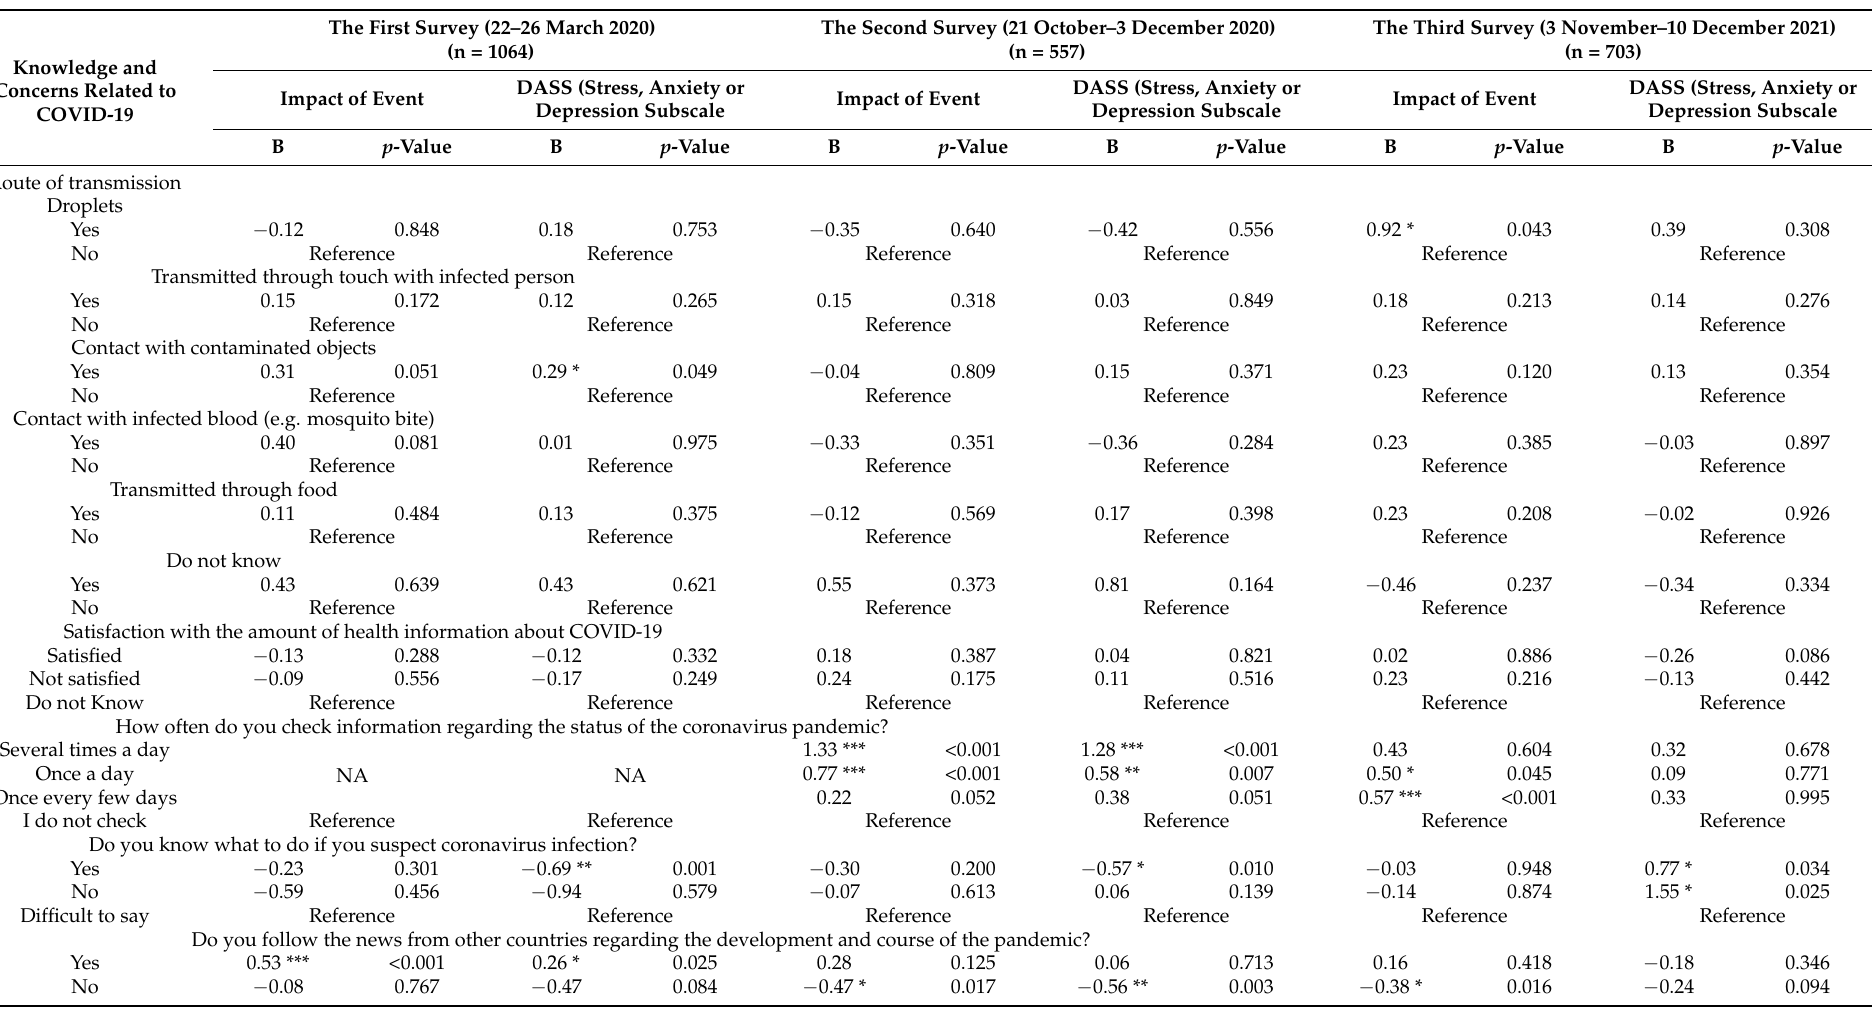
Table 3. Association of knowledge and concerns related to COVID-19 and the psychological impact as well as adverse mental health status during the first, second and third surveys (n =